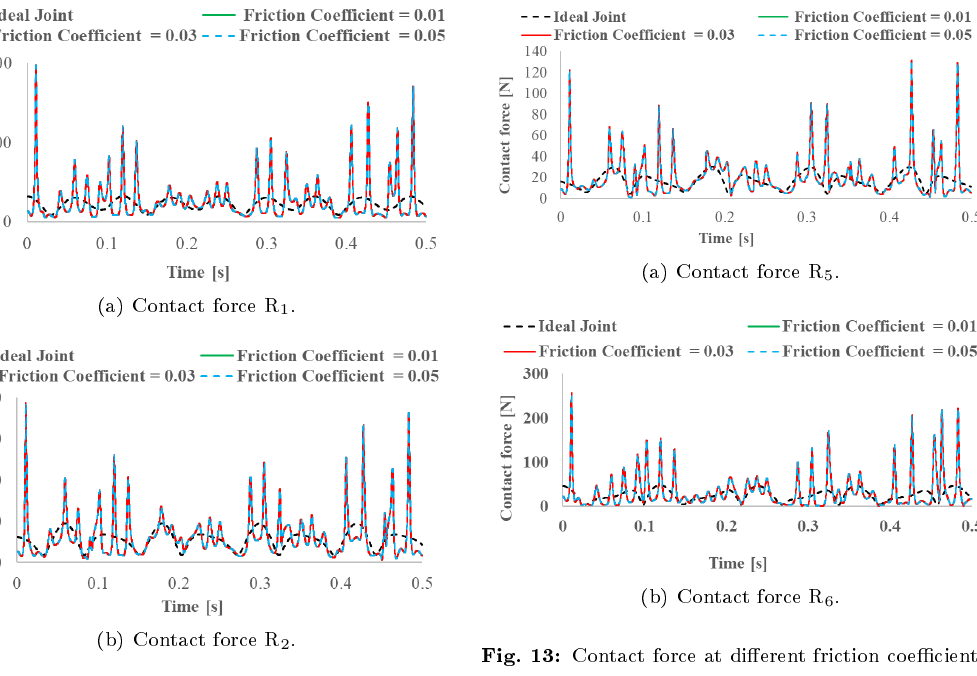
(a) Contact force R 5 .